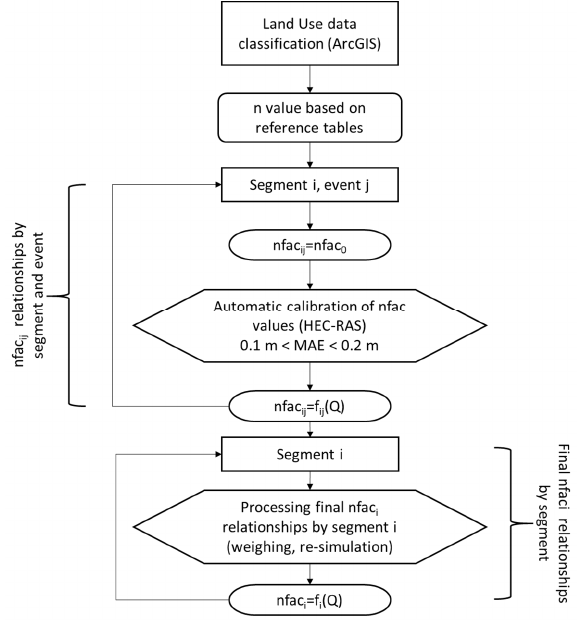
Figure 6. Adaptive calibration of the river model for each segment and event.